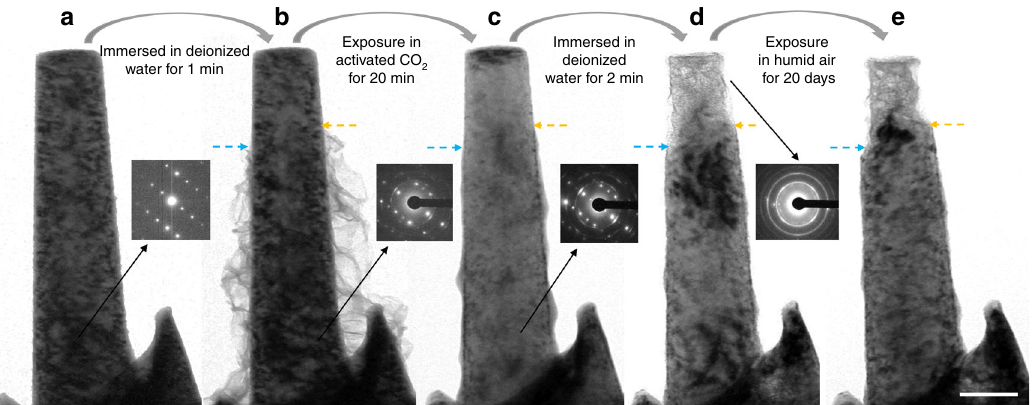
Fig. 4 Turning corroded Mg alloy surface into protective coating. a As-FIBed ZK 60 Mg alloy pillar and the corresponding selected area electron diffraction (SADP). b After immersion in deionized water for 1 min, some fl uffy Mg(OH) 2 &(MgO) corrosion product grew on the pillar ’ s surface. Note the top part was bare. c After the corroded pillar was exposed in CO 2 and the e-beam irradiation atmosphere for 20 min (only the part with fl uffy corrosion product was irradiated by e-beam), the newly formed MgCO 3 covered the bottom part of the pillar. d After water immersion, only the top part of the pillar was corroded. The region covered with MgCO 3 remained unchanged. e The top part was further corroded, and the protected part remained intact after exposure in humid air (relative humidity: 65 – 80%, temperature:18 – 26 °C) for 20 days. Scale bar, 200